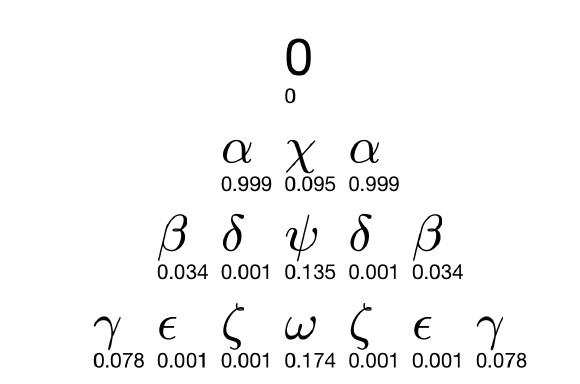
Figure 10. Values of weighting factors that maximize correlation between AMBIQUAL results and subjective MUSHRA